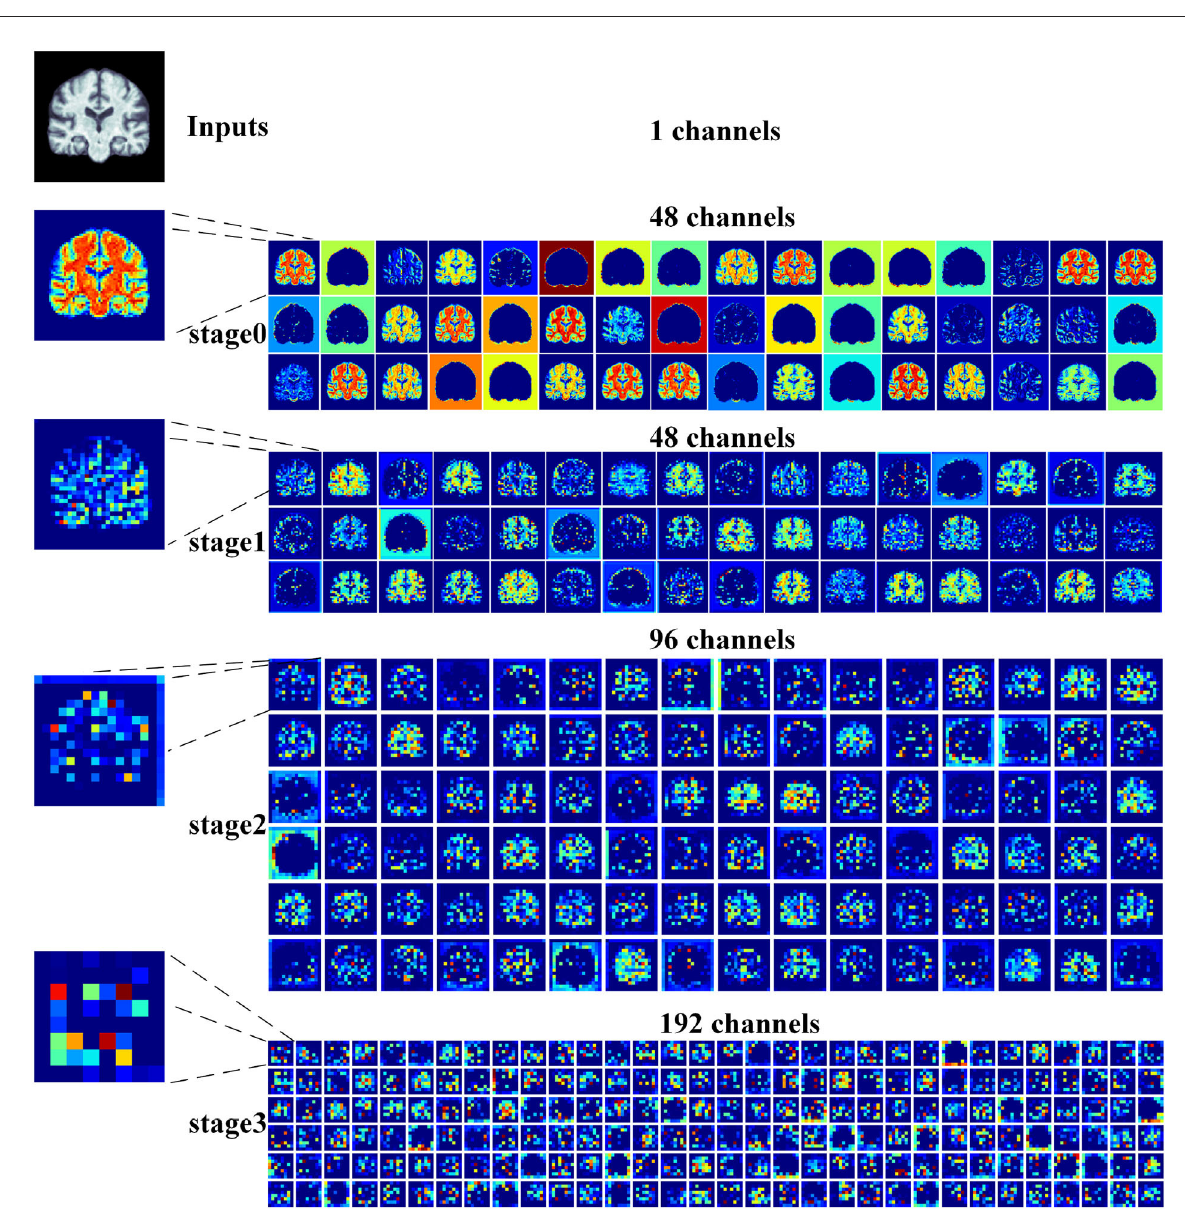
embedded into our proposed ResRepBlock, based on a re-